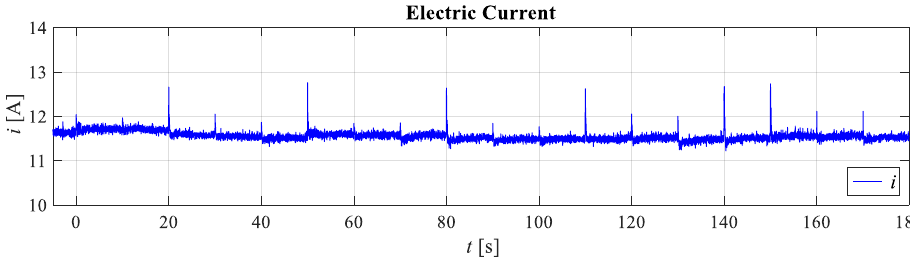
Figure 17. Experimental results of flat quadrotor configuration (FX4) response for attitude control.